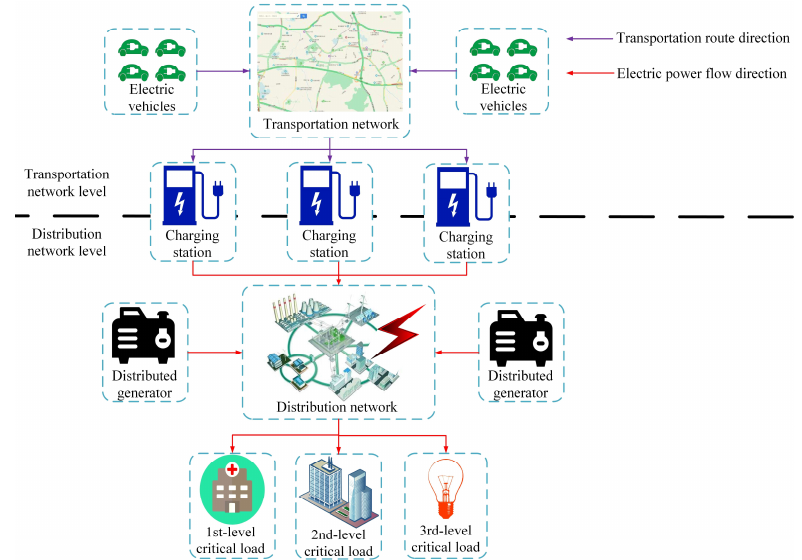
Figure 1. The configuration of the proposed strategy.